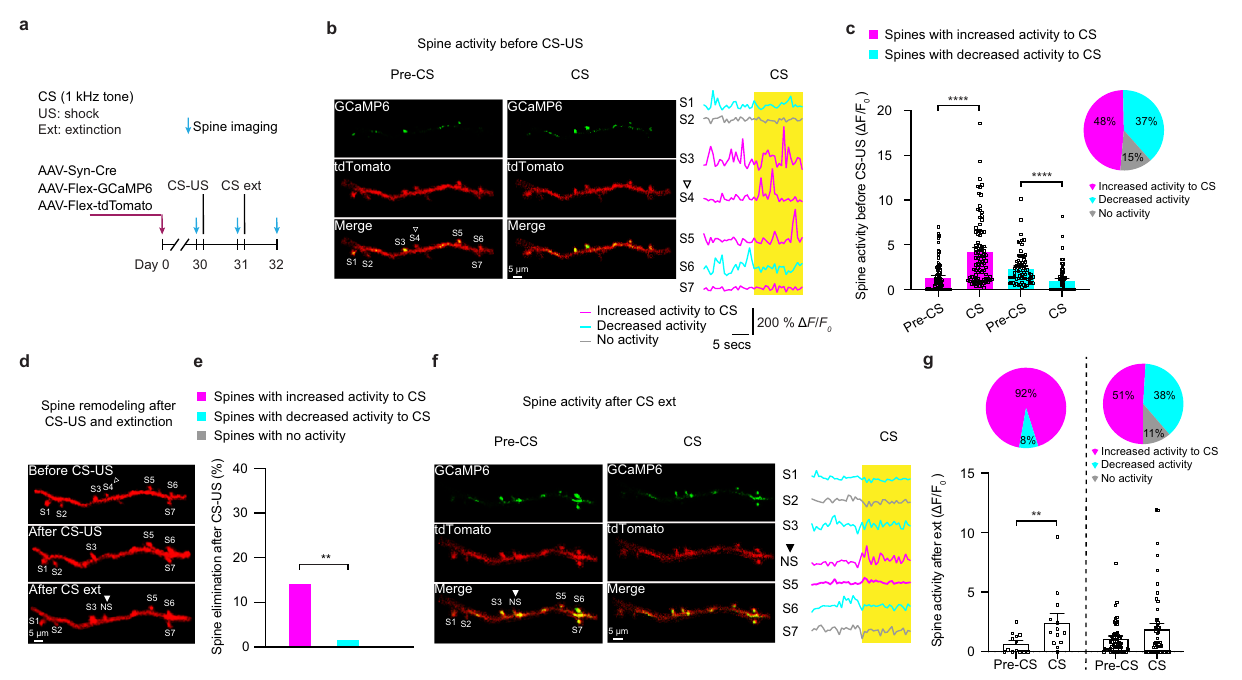
Fig. 2 | Fear conditioning and extinction-induced dendritic spine elimination and formation of layer 5 pyramidal neurons in the motor cortex likely con- tribute to neuronal activity changes. a Schematic of experimental design. Spine structure and Ca 2+ activity were examined with or without CS (1kHz) presentation before and after CS-US pairing and CS extinction. b Left and middle panels: Representative images of spine activity on apical dendrites of GCaMP6 and tdTo- mato co-expressing layer 5 pyramidal neurons with or without CS presentation before fearconditioning. Right panel: GCaMP6 fl uorescencetraces ofseven spines on the left panel without and with CS presentation. Yellow bar denotes the period of CS presentation. Experiments were repeated independently on 178 spines in 6 mice with similar results. c Percentage of spines showing increased or decreased activity or no activity in response to CS before fear conditioning. Spines were consideredshowingincreasedordecreasedresponsestoCSiftotal Δ F / F 0 ofspines during CS/pre-CS presentation periodwas ≥ 1 or<1, respectively(during CS vs. pre- CS, P <0.0001 respectively, Wilcoxon matched-pairs signed rank test). Total 178spineswereanalyzed. d Spineeliminationandformationafterfearconditioning and extinction. The hollow triangle indicates the spine (S4) eliminated on a